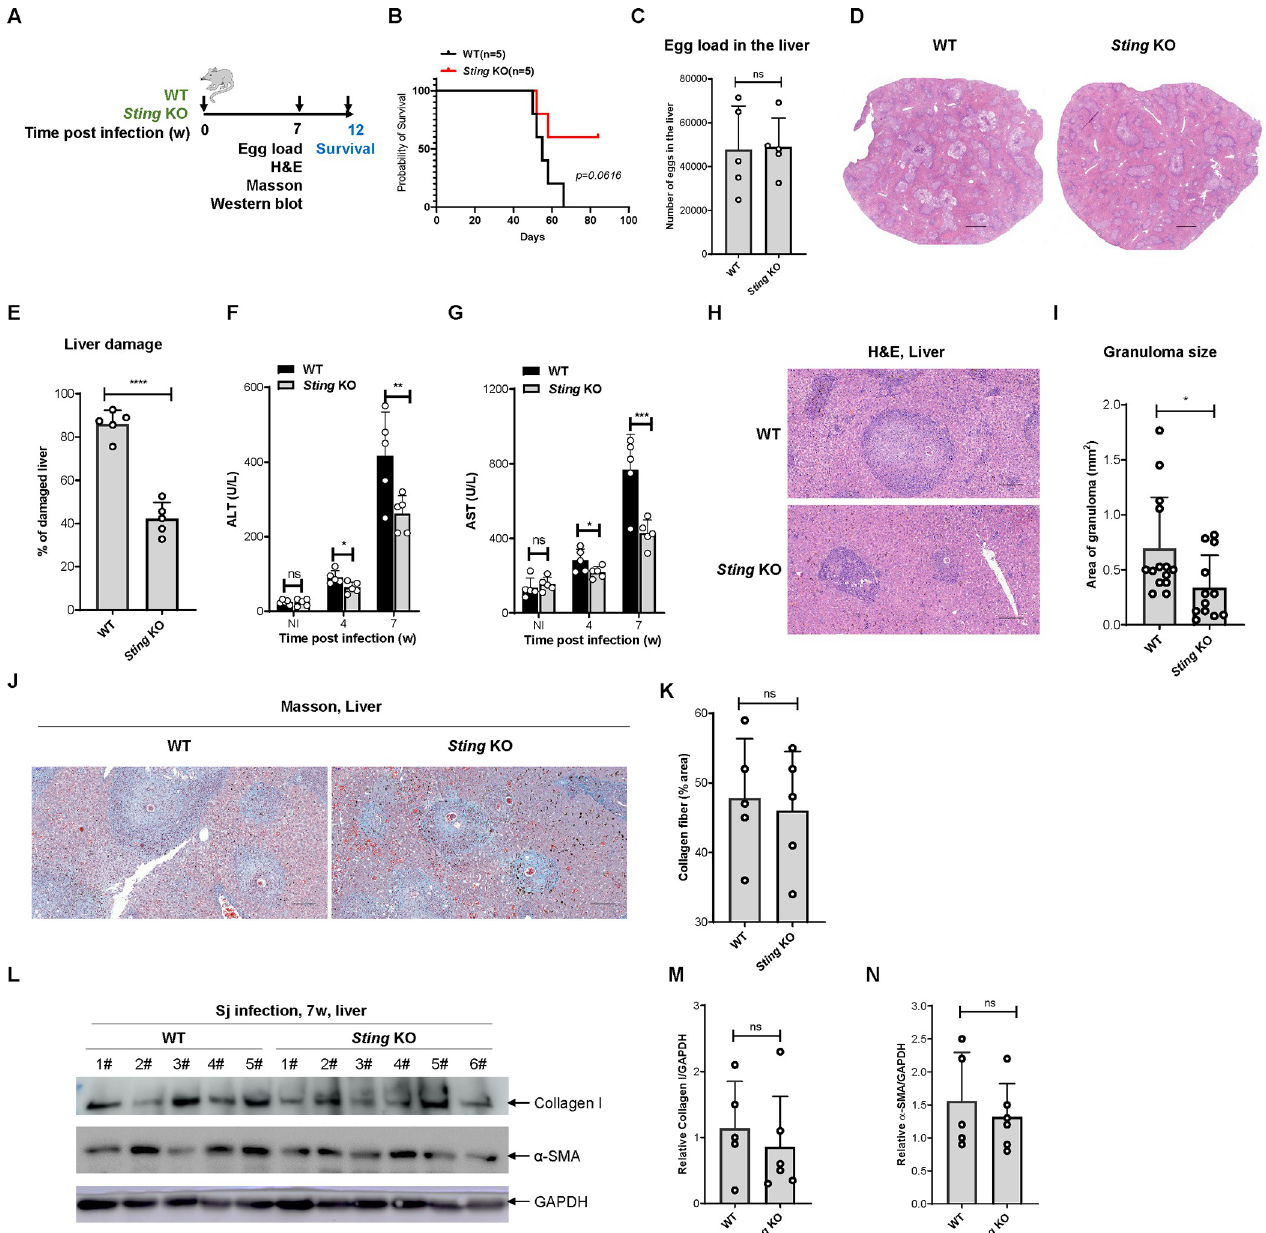
Fig 2. STING exacerbates Schistosoma japonicum infection in mice. (A) The scheme for monitoring of the survival of wild-type and Sting knockout mice infected with S . japonicum ; (B) The survival curve of wild-type and Sting knockout mice infected with S . japonicum . (C) The egg loads in the livers of wild-type and Sting knockout mice infected with S . japonicum . Data are expressed as the mean ± SD of the indicated number of mice from one of three independent experiments. (D-E) Representative imaging showing liver damage in the wild-type and Sting knockout mice infected with S . japonicum . Scale bar, 1 000 μ m. The quantification of the liver damage is shown in E. Data are expressed as the mean ± SD of the indicated number of mice from one of three independent experiments. (F-G) Measurement of the level of ALT (F) and AST in the sera of wild-type and Sting knockout mice left uninfected or infected with S . japonicum for the indicated times. Data are expressed as mean ± SD of indicated number of mice from one of three independent experiments. (H-I) Representative images showing egg-induced granulomas in the livers of wild-type and Sting knockout mice infected with S . japonicum . Scale bar, 200 μ m. The quantification of the area of the granuloma is shown in (I). Data are expressed as the mean ± SD of the indicated number of granulomas from one of three independent experiments. (J-K) Representative images showing Masson staining of the fibrosis in the livers of wild-type and Sting knockout mice infected with S . japonicum . Scale bar, 200 μ m. The quantification of the area of fibrosis is shown in (K). Data are expressed as the mean ± SD of the indicated number of mice from one of three independent experiments. (L-N) Western blotting detection of the indicated fibrosis-related proteins in the livers of wild-type and Sting knockout mice infected with Schistosoma japonicum . The quantification of gray intensity is shown in (M and N). An unpaired Student’s t-test was used for the statistical